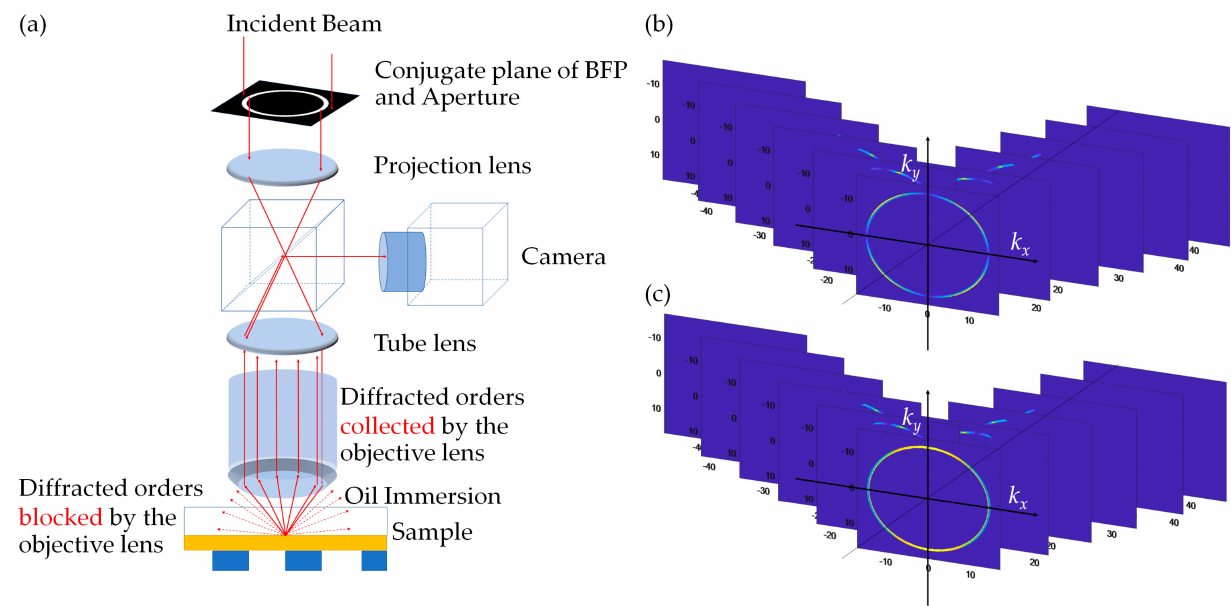
(cid:0) (cid:1) (cid:0) (cid:1) k x , k y E x , m k x , m , k y ,